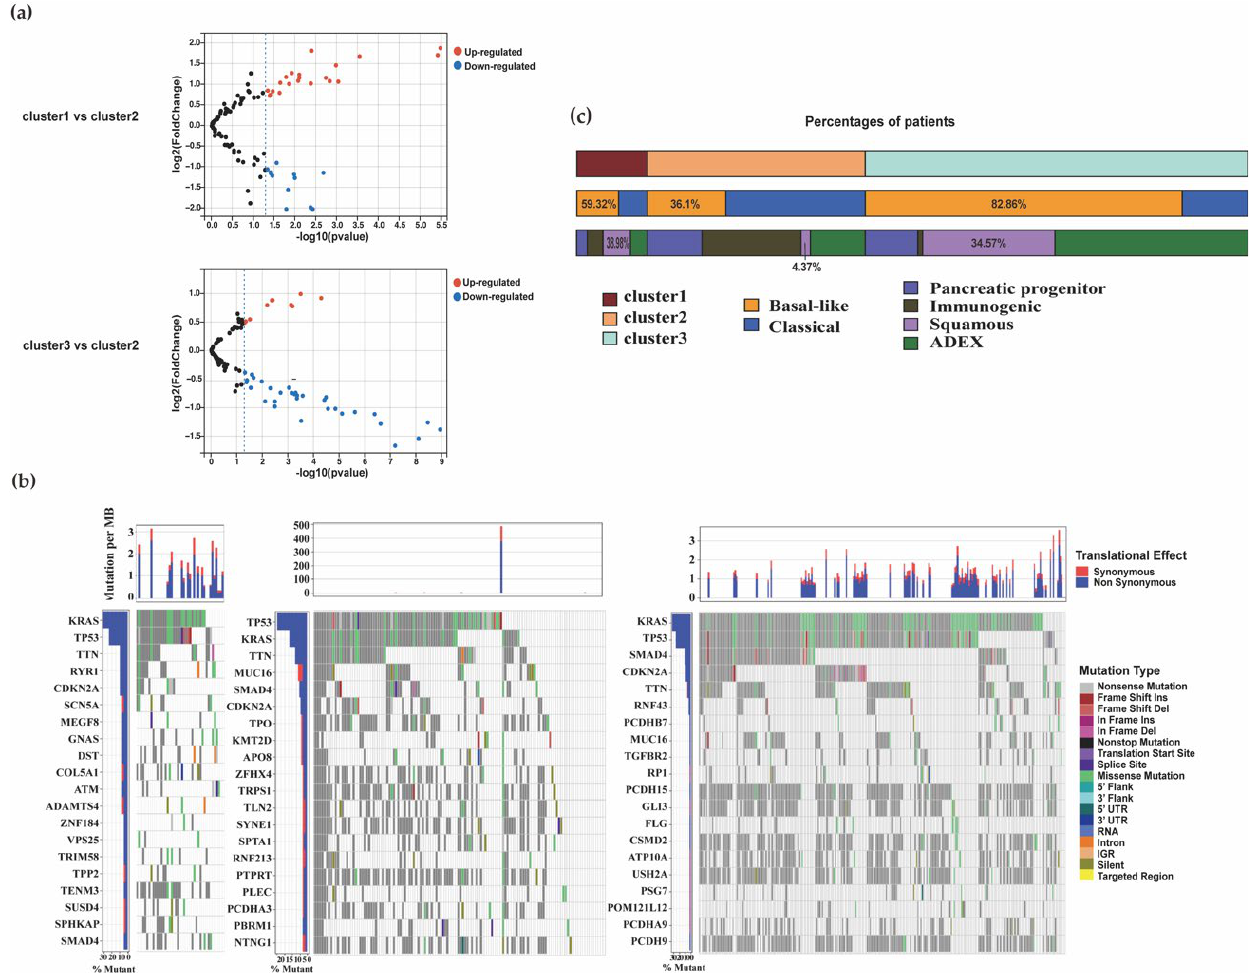
Figure 5. Characters of the PDAC subtypes and comparison with other prognostic subtypes. ( a ) The volcano charts of HIF-1-related genes among groups. ( b ) The somatic mutations and copy number mutations of the three clusters. ( c ) The comparison bar chart of the number of patients in PDAC subtypes with Moffitt and Bailey. (TCGA: https://portal.gdc.cancer.gov/, accessed on 17 May 2021;